Question: Which kind of chart has been used to present this data?
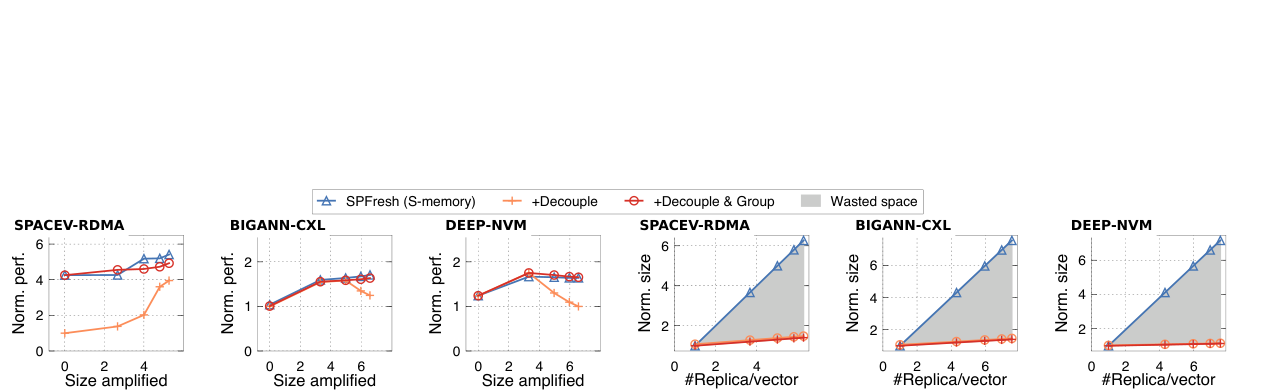
Answer: line